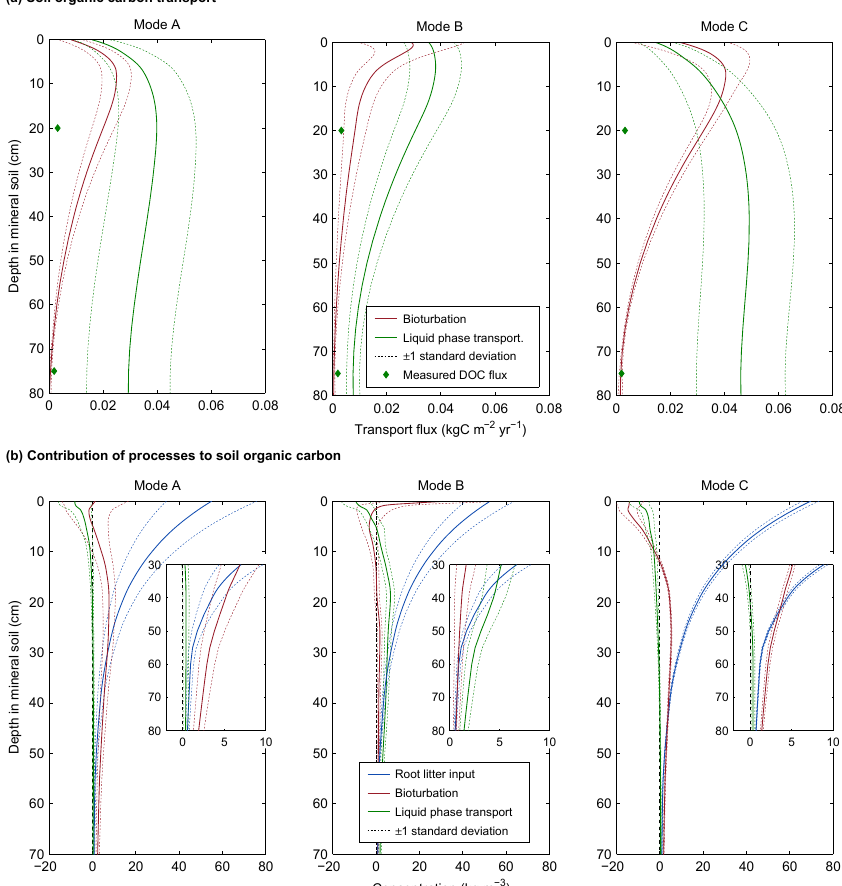
Fig. 9. Simulated organic carbon fluxes from forward Monte Carlo simulations for Hainich, based on the three modes of the posterior distribution of calibration setup 3 (note the different scales on the y-axes). All quantities are averages over the last simulation year and the Monte Carlo ensemble. (a) Organic carbon transport fluxes and measured dissolved organic carbon (DOC) fluxes (Kindler et al., 2011; not used in the calibration); (b) contribution of the different processes to soil organic matter profile in mineral soil (see Sect.